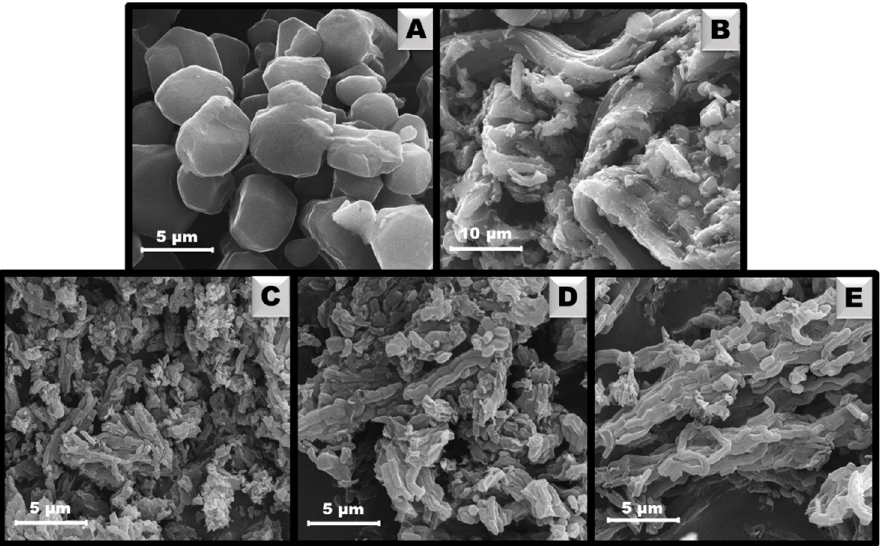
Figure 4. SEM images of ordered mesoporous carbons: C AP-L ( A ), C AP-H ( B ), C SBA-15 ( C ), C CH-L ( D ), and C CH-H ( E ).